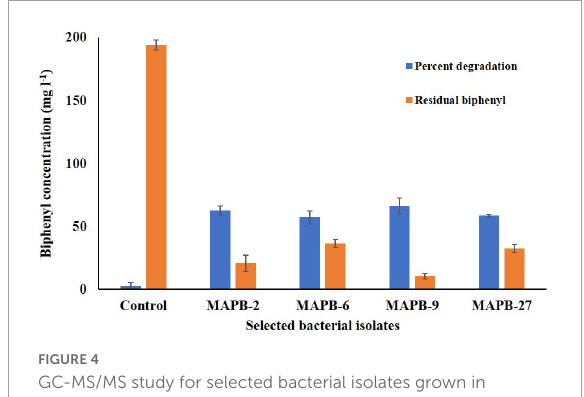
FIGURE4 GC-MS/MS study for selected bacterial isolates grown in minimal media supplemented with 200 mg/l biphenyl at 30 ◦ C for 48 h, 150 rpm.